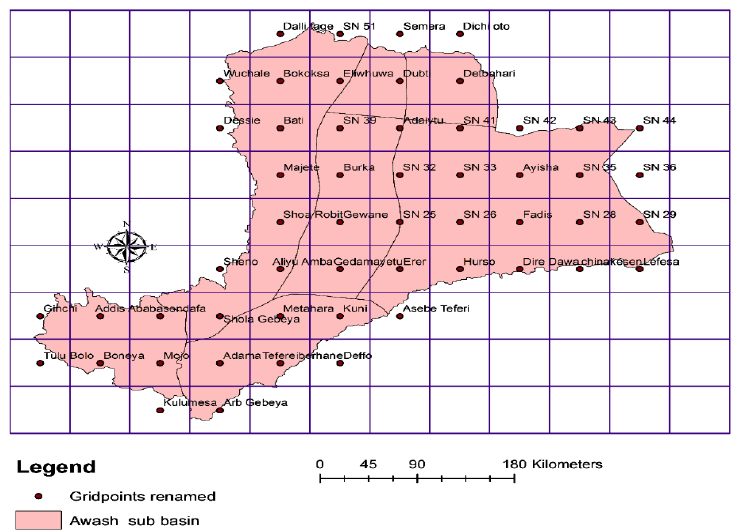
◦ by 0.5 ◦ grid (Renamed after nearby cities or serial number, Figure 3. Data points on the 0.5° by 0.5° grid (Renamed after nearby cities or serial number, SN). Figure 3. Data points on the 0.5